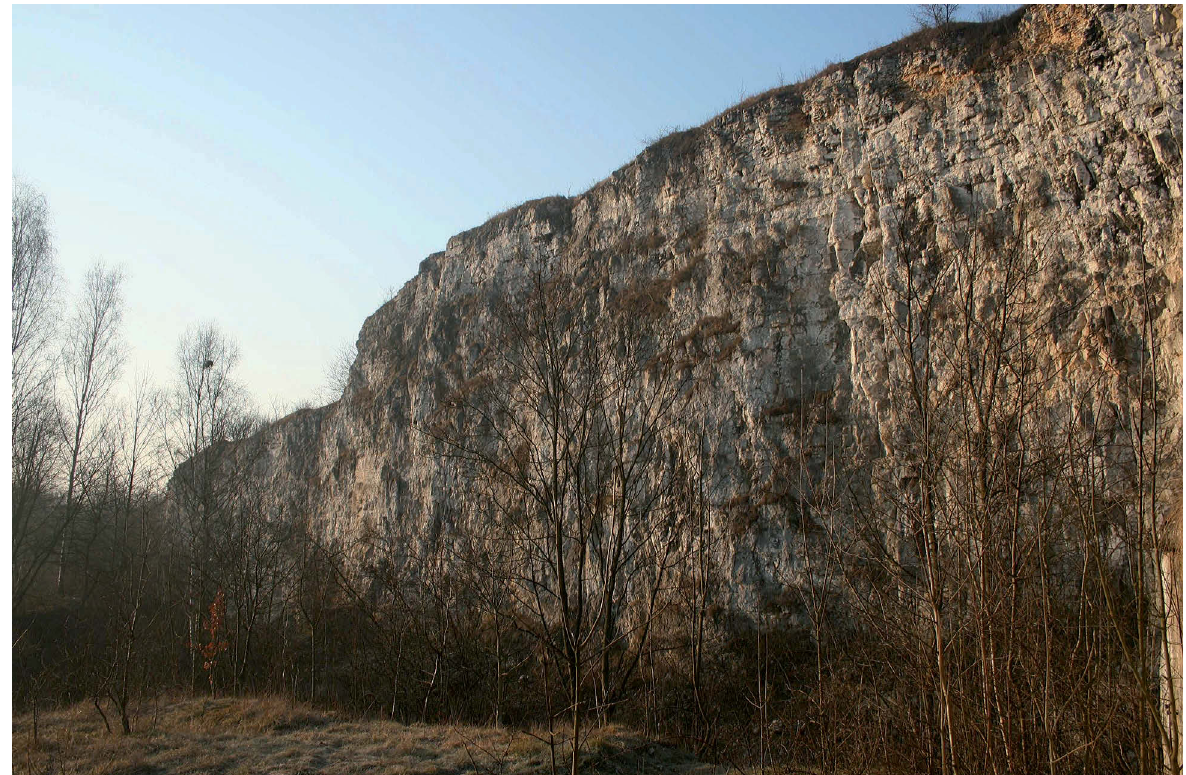
Fig. 3. Renaturalised landscape in the area of Zakrzówek Lake